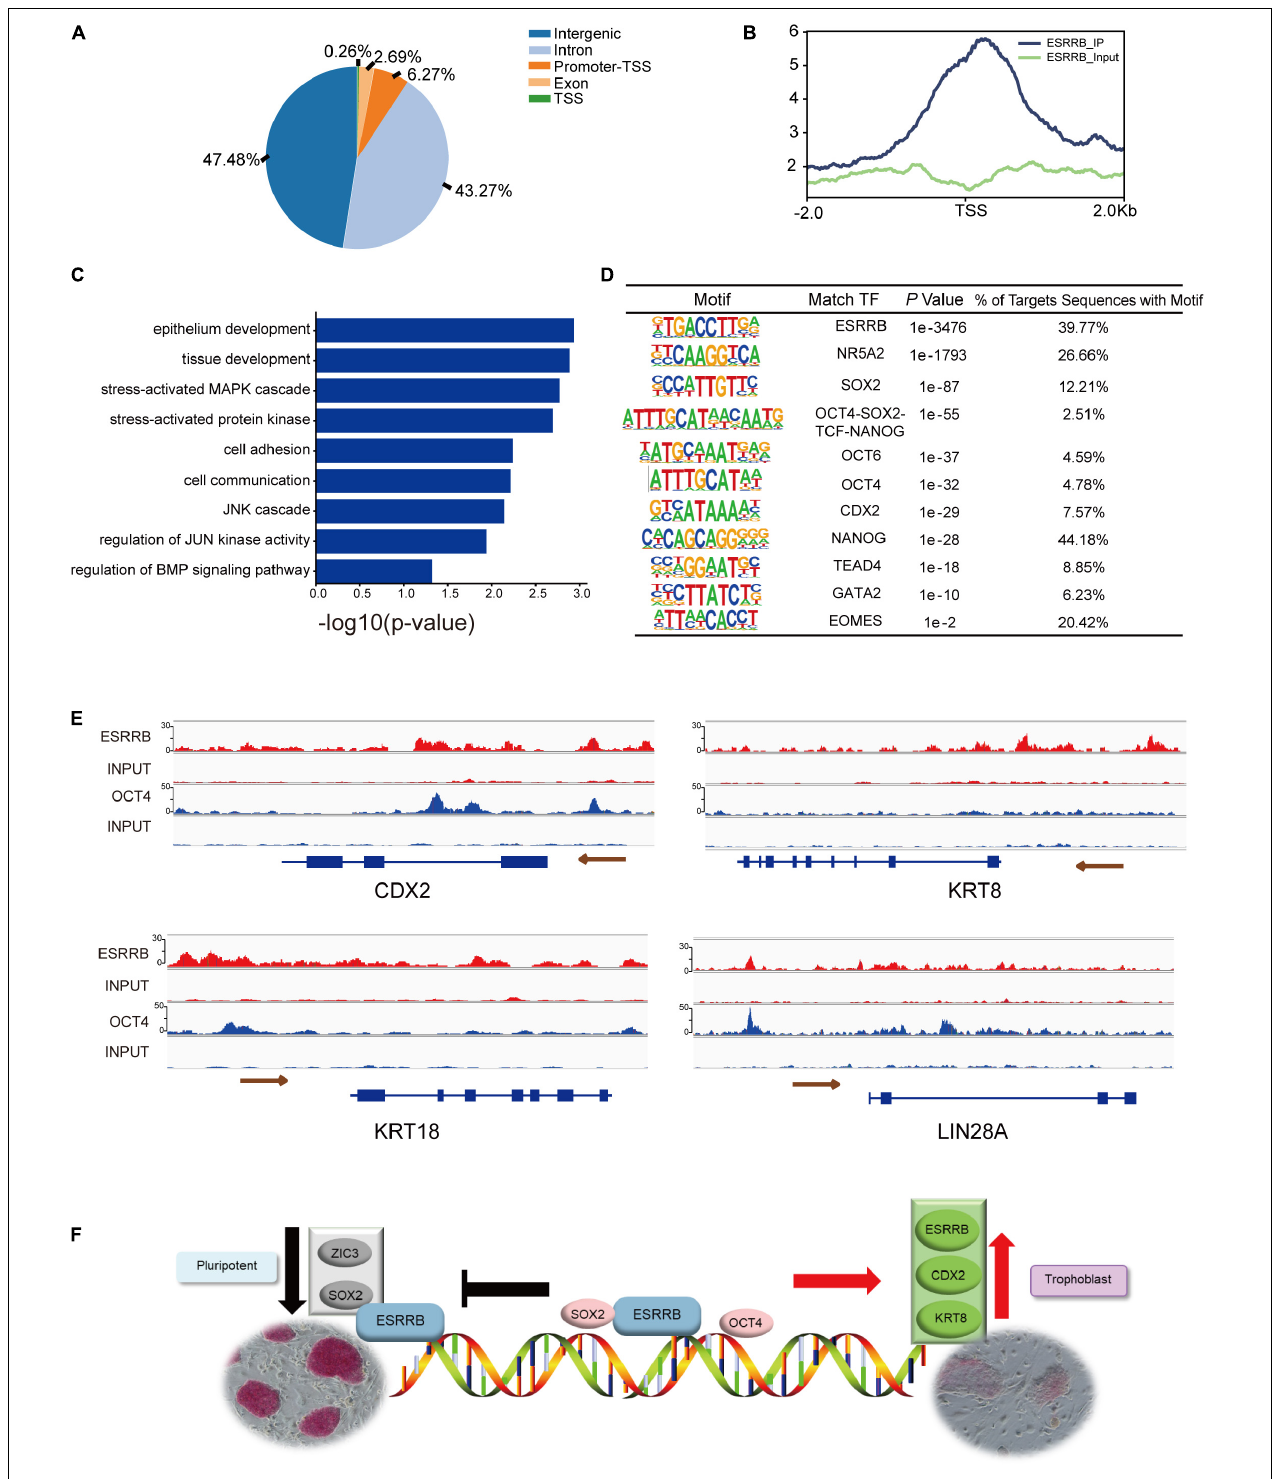
FIGURE 7 | Chromatin immunoprecipitation (ChIP)-seq analysis for genes targeted by ESRRB. (A) Fraction of ESRRB-FLAG binding sites within various regions of the genome. (B) The profiles of peak signals of ESRRB-FLAG. Signals are shown for 2.0 kb up- and downstream of the transcription start site (TSS). (C) The GO enrichment of ESRRB peak correlative genes. (D) The motifs of ESRRB were identified. (E) ChIP-seq analysis of ESRRB marks at pluripotent and TSC gene loci in ESRRB-piPSCs using IGV. The size of the peak represents the degree of enrichment. (F) The model for action for OCT4, KRT8, CDX2, and ESRRB during pluripotency and trophoblast